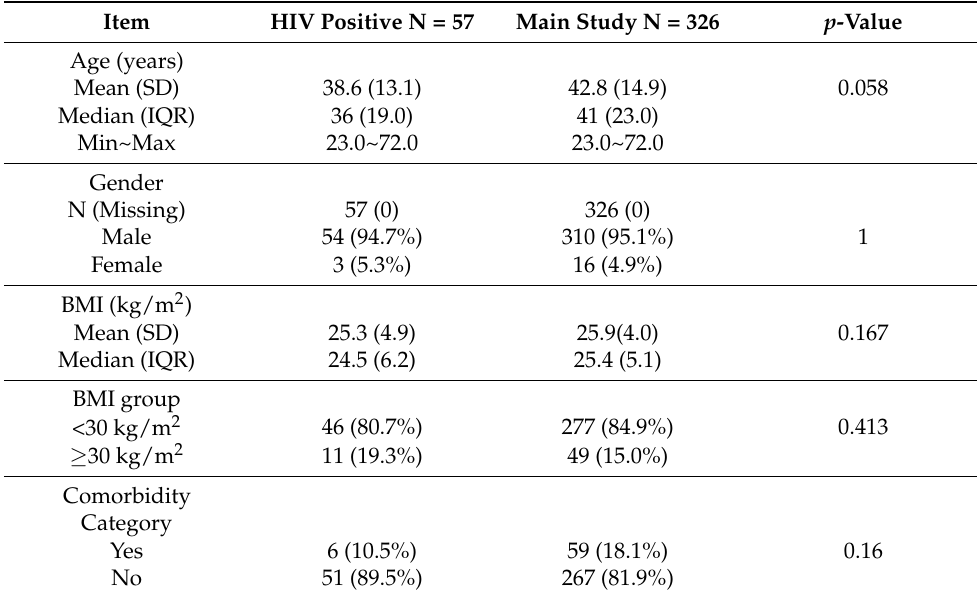
Table 1. Demographic characteristics of the matched